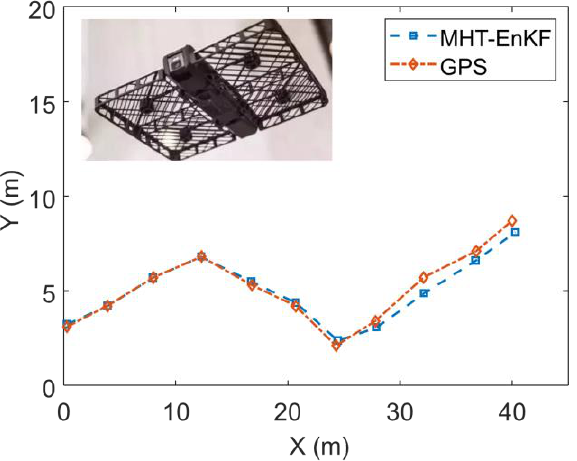
Figure 9. A comparison of the results of the trajectory fitting results based on the improved EnKF method with KF, EKF and PF.